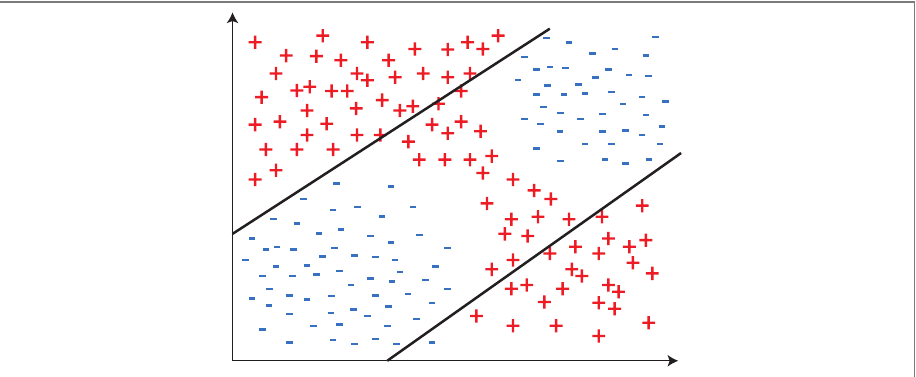
Fig. 1. Groups of objects cannot be separated using straight lines (hyperplanes in a two-dimensional space) that represent linear